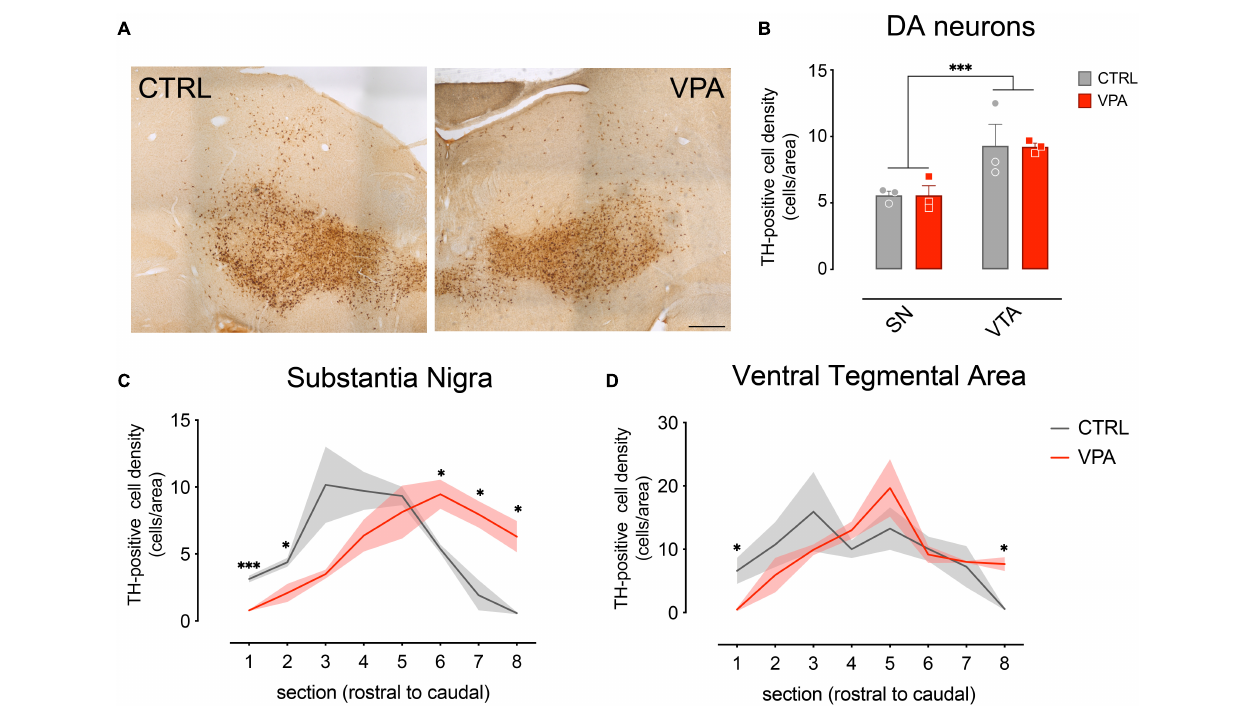
FIGURE 1 | Immunohistochemical analysis and quantification of cell densities. (A) Brain sections from CTRL and VPA chicks immunolabeled for Tyrosine Hydroxylase (TH). (B) Number of TH-positive DA neurons in both SN and VTA. TH-positive cells count was performed on 8 sets of serial sections per animal, sampled at 300 µ m intervals. Rostro-caudal alignment of the brain sections was based on atlas reference (Plate 34 from Puelles et al., 2007). (C) Substantia Nigra DA cell density measured in its rostro-caudal distribution. (D) Ventral Tegmental Area DA cell density measured in its rostro-caudal distribution. Scale bar 500 µ m. ∗ p < 0.05, ∗∗∗ p <